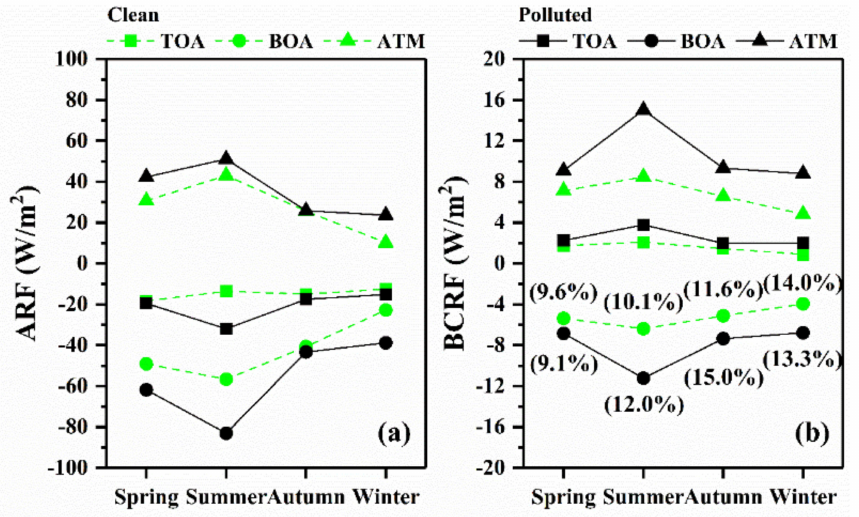
Figure 7. Multi-year seasonal mean of ( a ) ARF; ( b ) BCRF at TOA, BOA, and ATM in Wuhan, China from 2013 to 2016. The values in parentheses indicate the proportion of BCRF in the corresponding ARF at